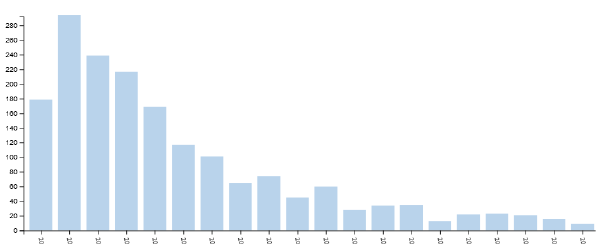
Figure 4. Number of results for query: All = ( benchmark * and ( photogrammetry or remote sensing )) in the Web of Science